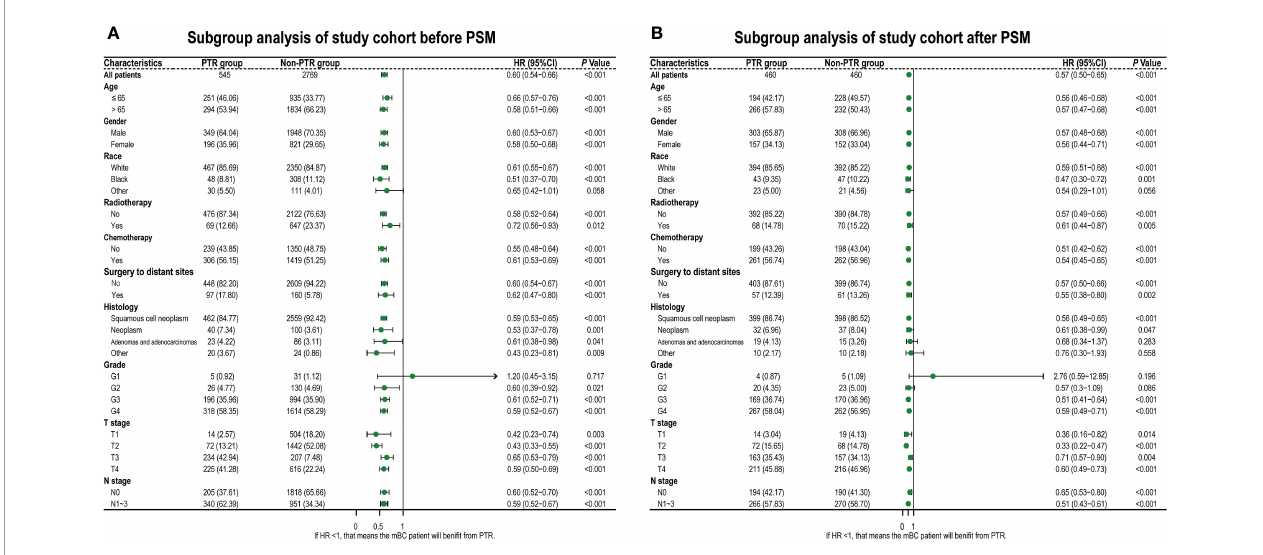
FIGURE 2 | Hazard ratios of overall survival for PTR group and non-PTR groups. Diamonds represent effect size, calculated separately in different subgroups, and error bars indicate 95% CIs. (A) Before PSM. (B) After PSM. PTR, primary tumor resection; PSM, propensity score matching.